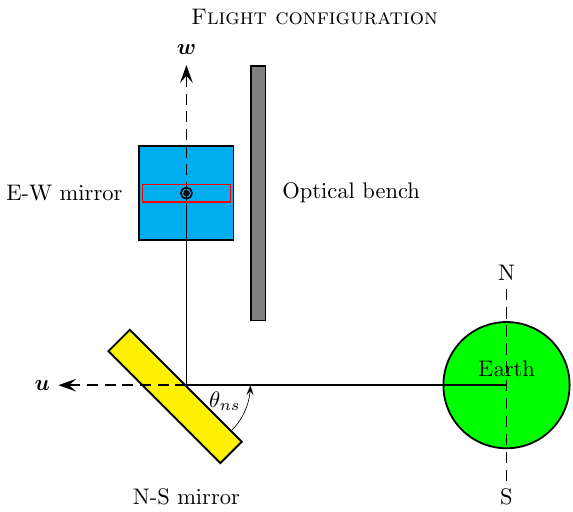
Figure 2. The schematic shows the coordinate system and orthogo- nal unit vectors u , v and w used for geoCARB. The nadir direction from the centre of the north–south scan mirror to the centre of the earth defines the negative u axis. The positive v axis points east- ward along the equator. In the schematic, it is represented by the arrowhead emerging from the page in the centre of the east–west scan mirror. The w axis, defined by w = u × v , points to the north. The optical bench is parallel to the satellite platform, and its nor- mal vector is parallel to u . The image of the slit on the east–west scan mirror is indicated by the red rectangle. The slit also is parallel to u . The north–south scan mirror rotates about the v axis through the angle denoted θ ns in the schematic. The east–west scan mirror rotates about the u axis through angle θ ew (not